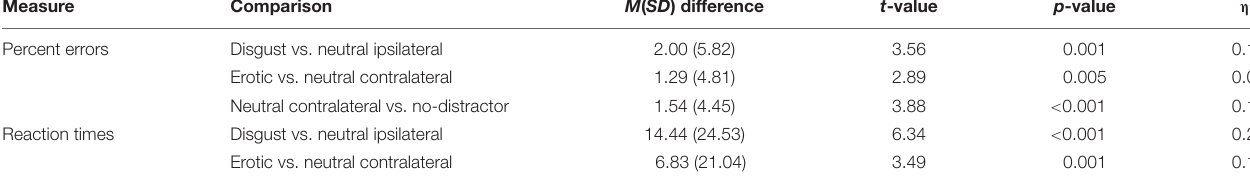
TABLE 1 | Results of within-subject t -tests of percent errors and reaction times (RTs). Measure Comparison